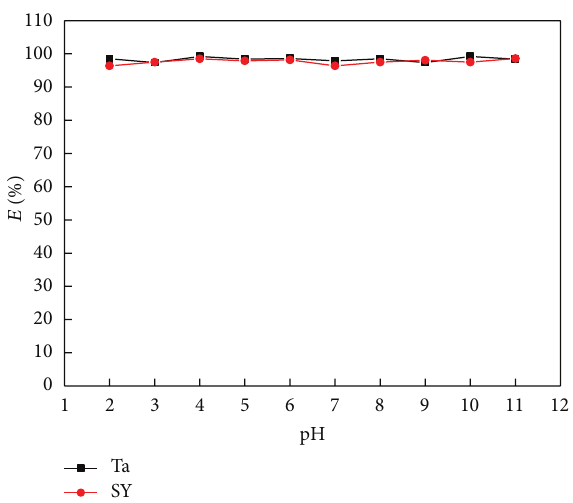
Figure 2: The effect of pH on the extraction efficiency ( 𝑚 = 100 𝜇 g, 𝑉 = 0.30 mL). 100 𝜇 g, 𝑚 Ta IL